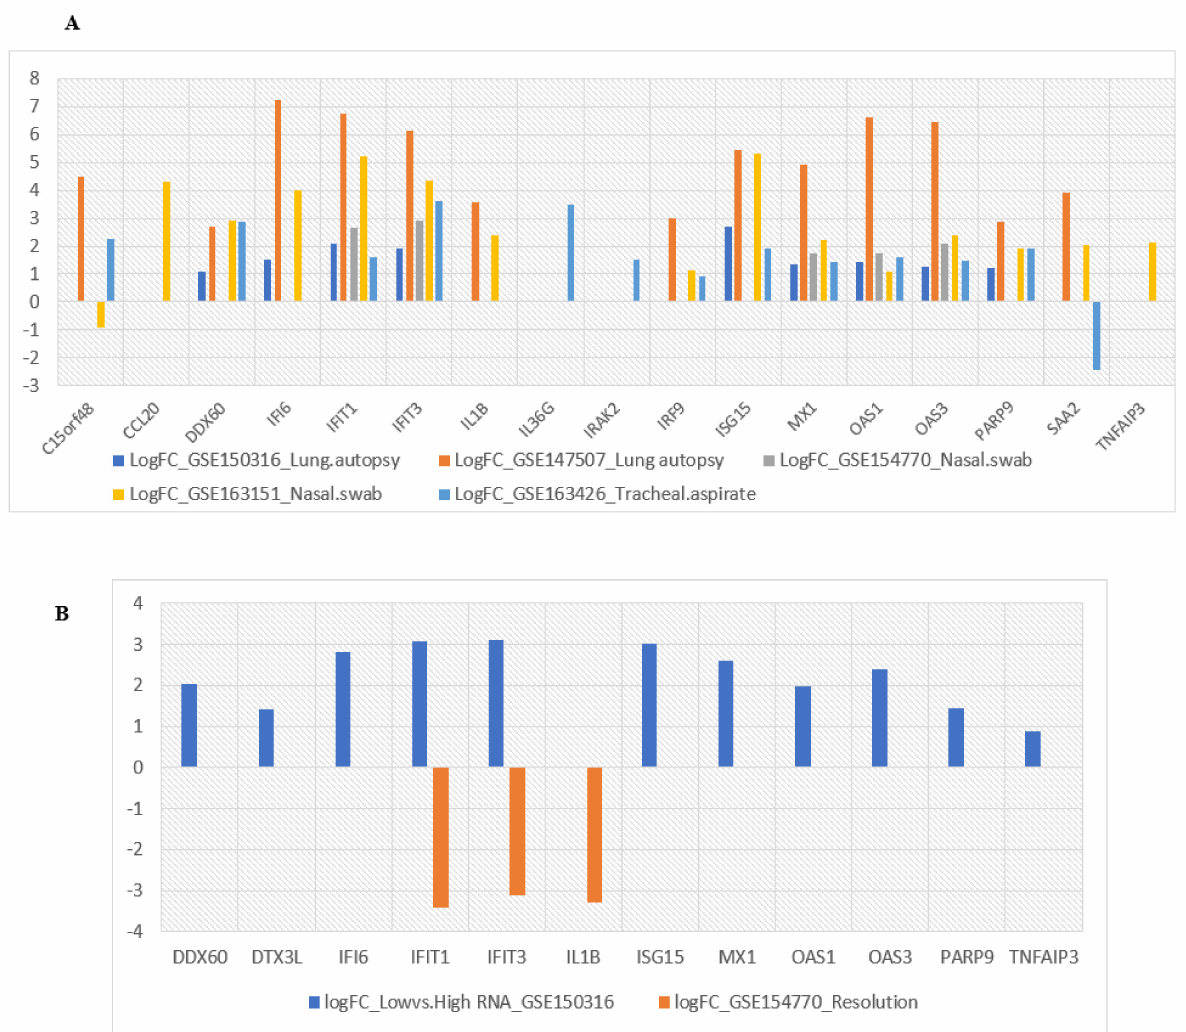
Figure 7. ( A ) Comparison of the expression level of selected hub genes in respiratory specimens of COVID-19 patients; ( B ) Evaluation of transcriptional changes in identified hub genes in samples with high versus low SARS-CoV-2 viral load alongside their differential expression over the course of SARS-CoV-2